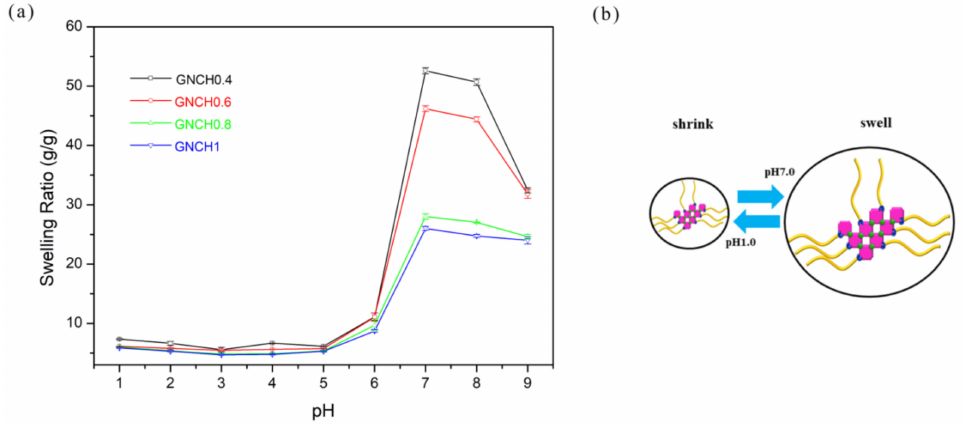
Figure 6. ( a ) Variation of swelling capacity for GNCH at the bu ff er solution with various pH values. ( b ) An illustration of the size comparison of GNCH at di ff erent pH